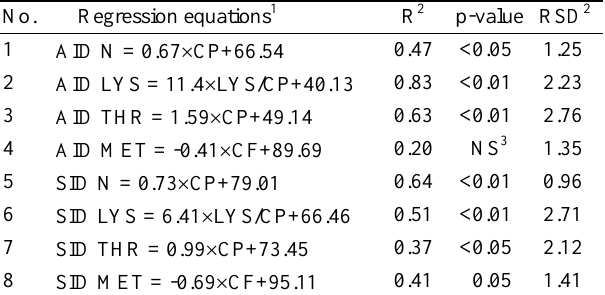
Table 11. Prediction of amino acid digestibility (% as fed) from chemical composition (% of DM) in wheat shorts and red dog No. Regression equations 1 R 2 p-value RSD 2